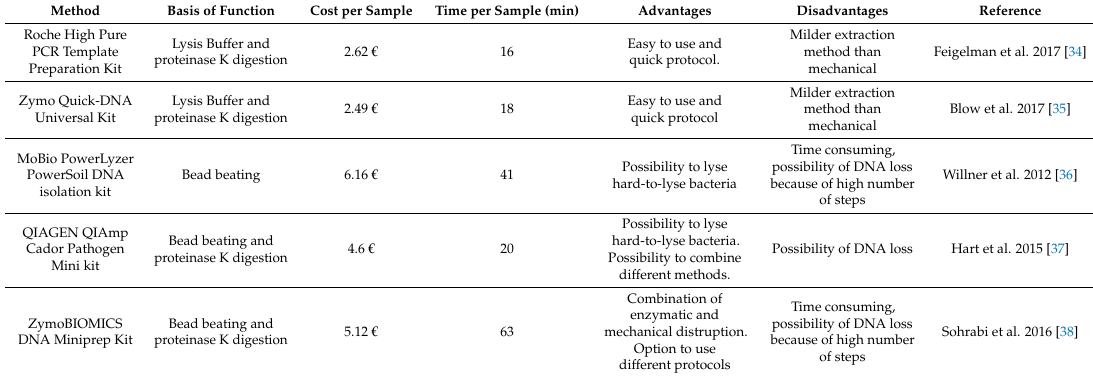
Table 1. Comparison of different methods for DNA extraction (Information provided by manufacturer’s instructions and